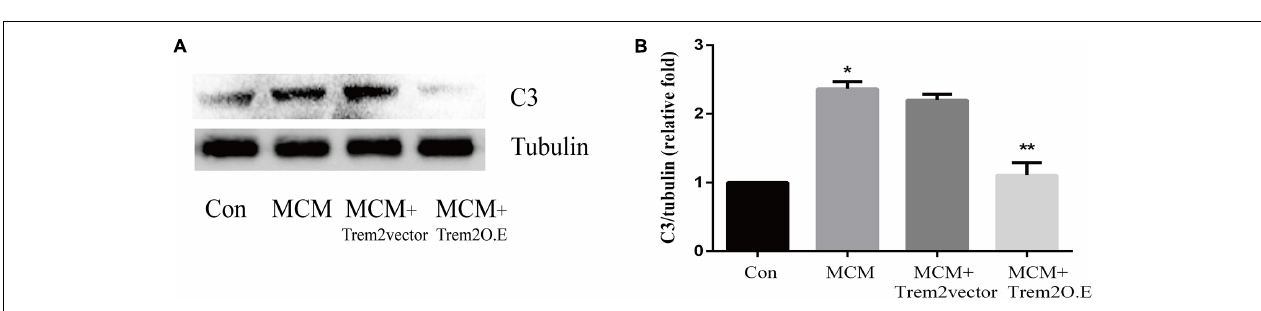
FIGURE 9 | Triggering receptor expressed on myeloid cells 2 (TREM2) protein level was quantitatively measured after TREM2 (vector or overexpression) plasmid transfection in BV2 cells. (A) Western blot analysis of TREM2 (Myc-tagged) protein expression. (B) Quantitative analysis of TREM2 (Myc-tagged) protein expression. * p < 0.05 vs. control of each protein. The data are expressed as means ± standard deviation (SD) from three independent experiments.